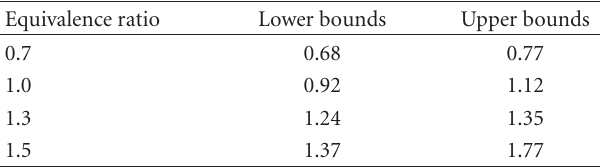
Table 3: Observed variability in equivalence ratio. Equivalence ratio Lower bounds Upper